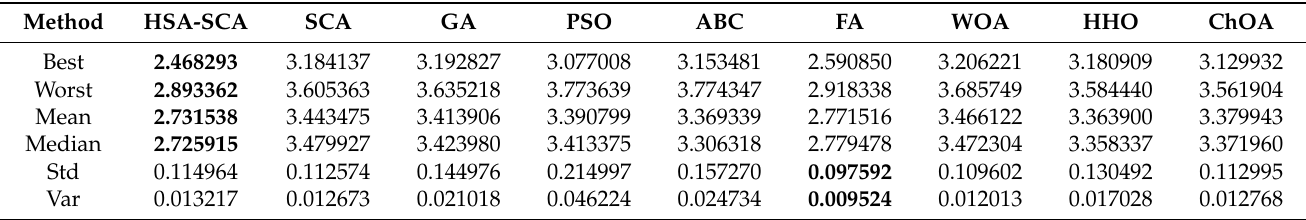
Table 1. Comparative results of the objective function (MSE) of the observed